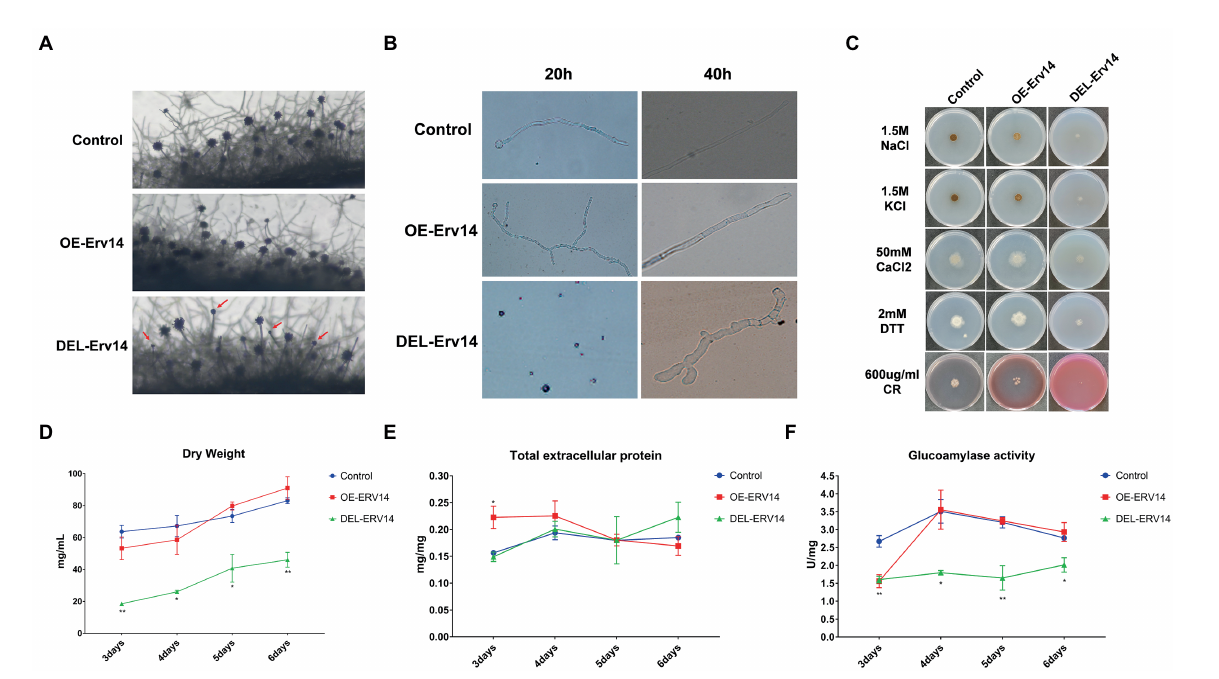
FIGURE 2 Effect of knockout and overexpression of ERV14 on spore germination and protein secretion in A. niger . Comparison of the morphology of the conidial peduncle (A) and germination of spores (B) of OE-Erv14 and DEL-Erv14 strains. (C) Morphological phenotypes of the OE-Erv14, and DEL-Erv14 strains on plates with different environmental stress. The control and mutant strains were cultivated on CD medium with different drugs for 7 days (KCl, NaCl, CaCl 2 for salt ion pressure, DTT for reducing pressure, and CR(Congo Red)for cell wall interference). Consecutive measurements of dry weight (D) , total extracellular protein (E) and glucoamylase enzyme activity (F) in extracellular proteins of OE-Erv14 and DEL-Erv14 strains from 3 to 6 days. CBS Δ ku strain was used as the control. The values of secreted protein and enzyme activity were normalized by dry